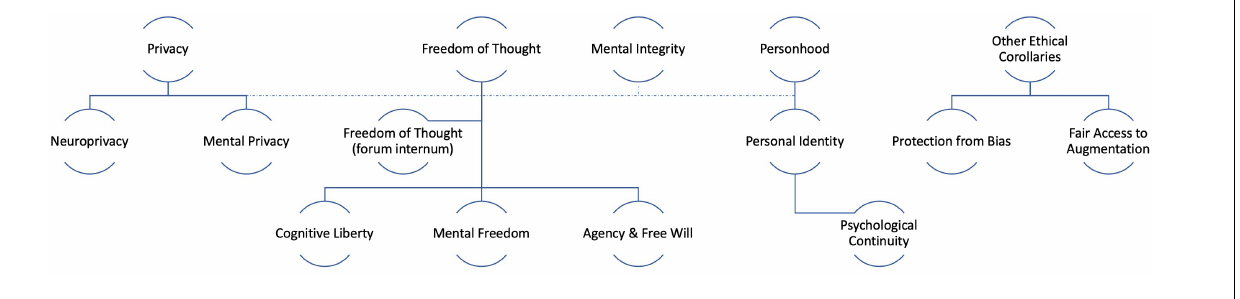
FIGURE 1 | A taxonomy of